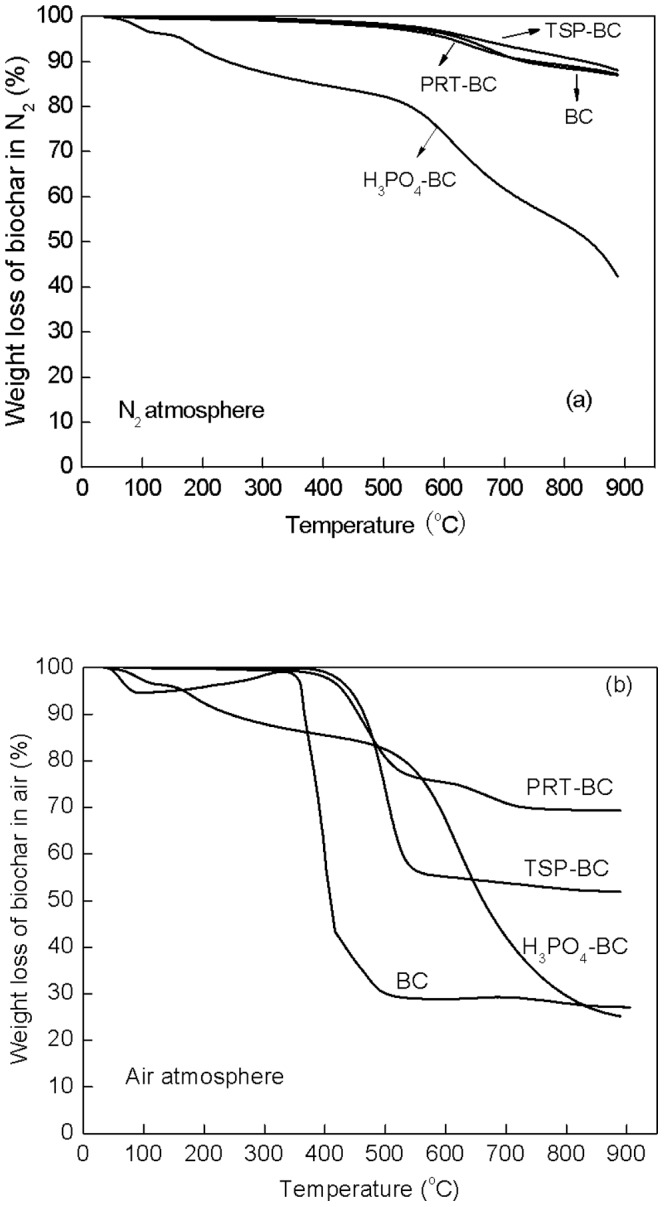
TGA curves of the biochars in N2 (a) and air (b) atmosphere.